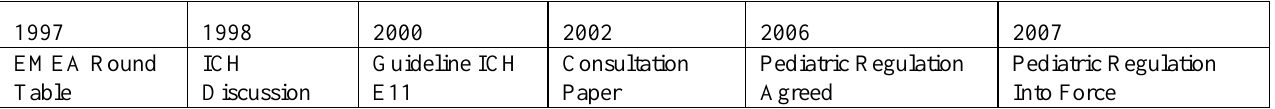
Consultation Paper